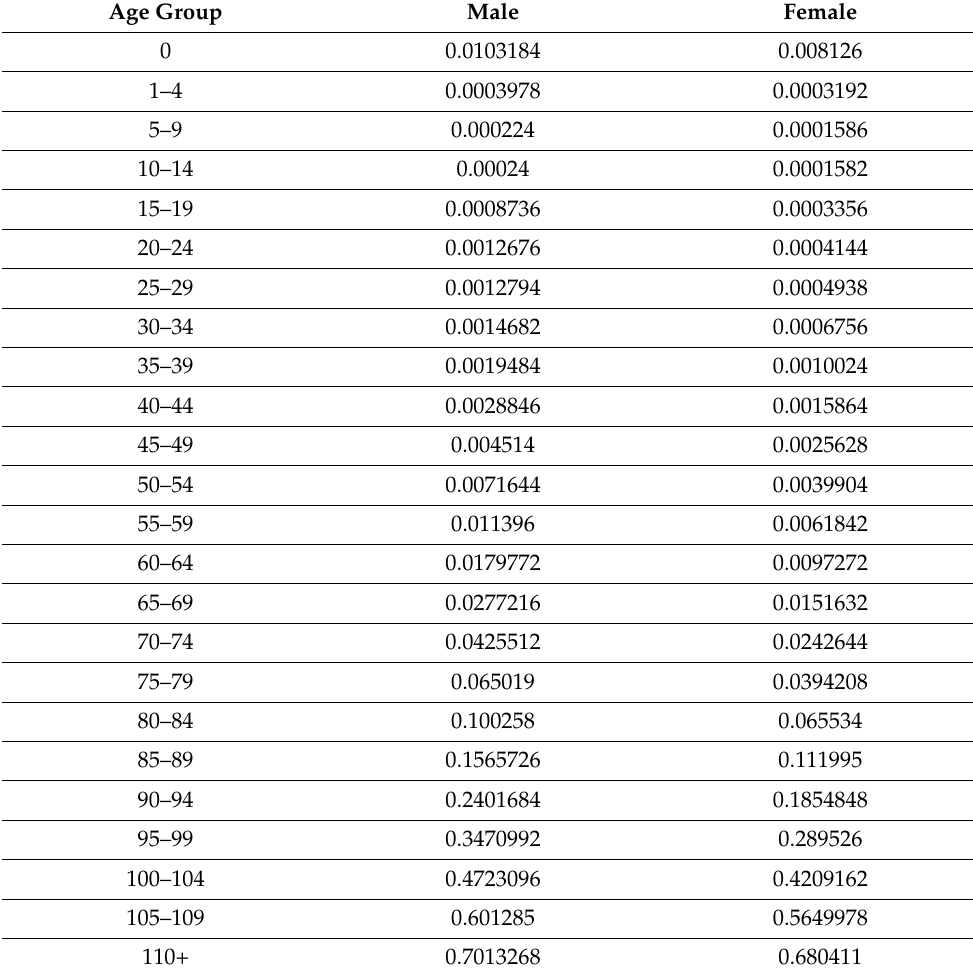
Table 2. Average mortality rates by age groups and